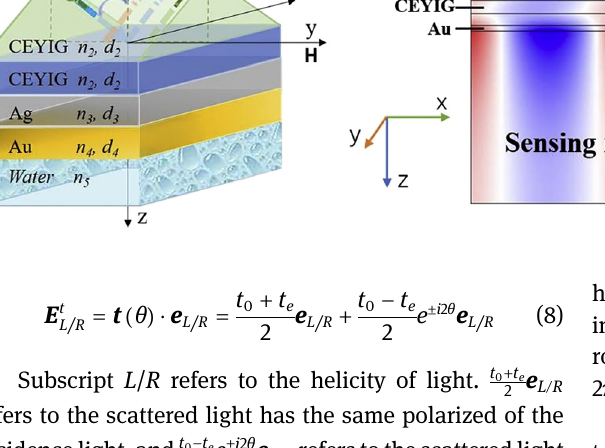
Figure 6: (a) Illustration of PSHE in an SPR